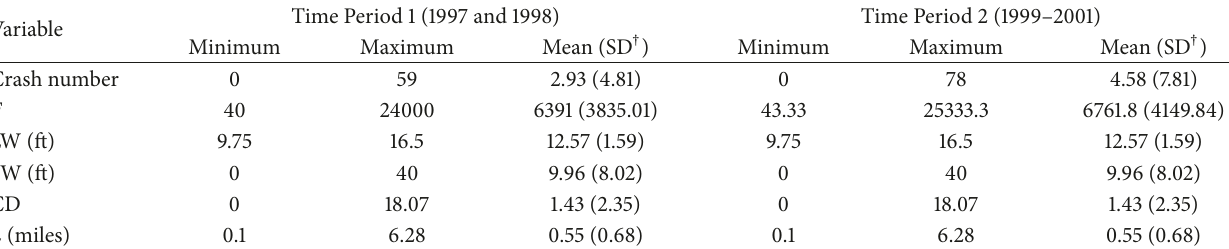
Table 2: Summary statistics for road segments in Texas rural undivided highways dataset.